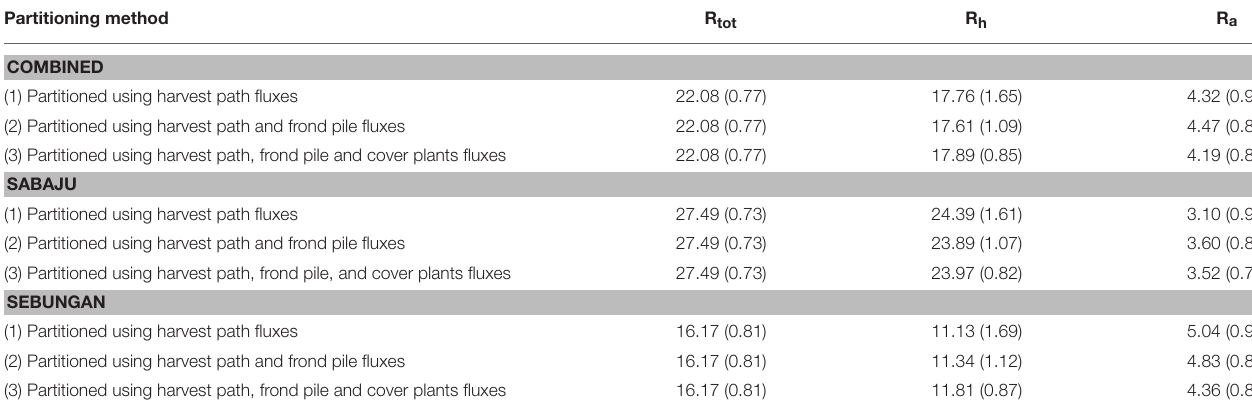
TABLE 5 | R tot , R h and R a estimates from both plantations combined, and Sabaju and Sebungan considered individually. Partitioning